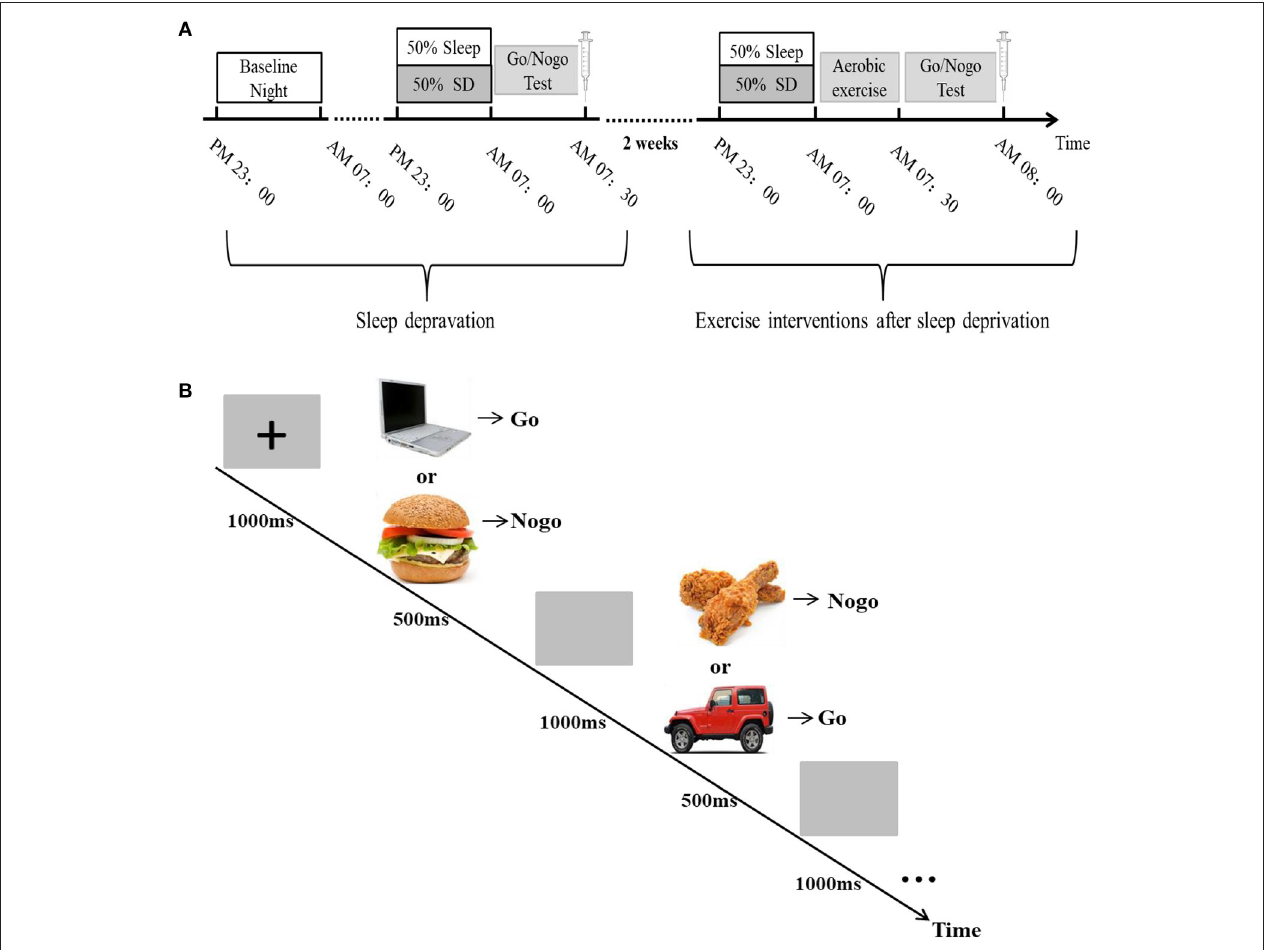
FIGURE 1 | Flow chart of test procedures. (A) A randomized crossover experimental design process. All subjects are required to participate in a sleep deprivation and a normal sleep experiment, with an interval of 2 weeks. The sleep intervention time is PM23:00-AM07:00. Sleep in the basal state (baseline night) was performed once before the experiment, and a Go/NoGo experiment and blood sample collection between 07:00 and 08:00 after the sleep intervention. (B) Go/NoGo experimental